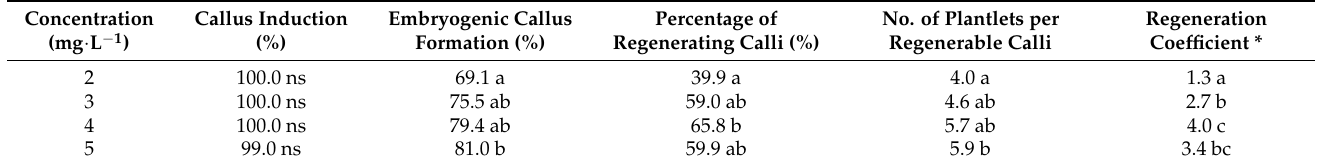
Table 2. The effect of Dicamba concentrations on morphogenic callus production and plant regenera- tion in immature embryo-derived cultures of Triticum urartu , spring accession